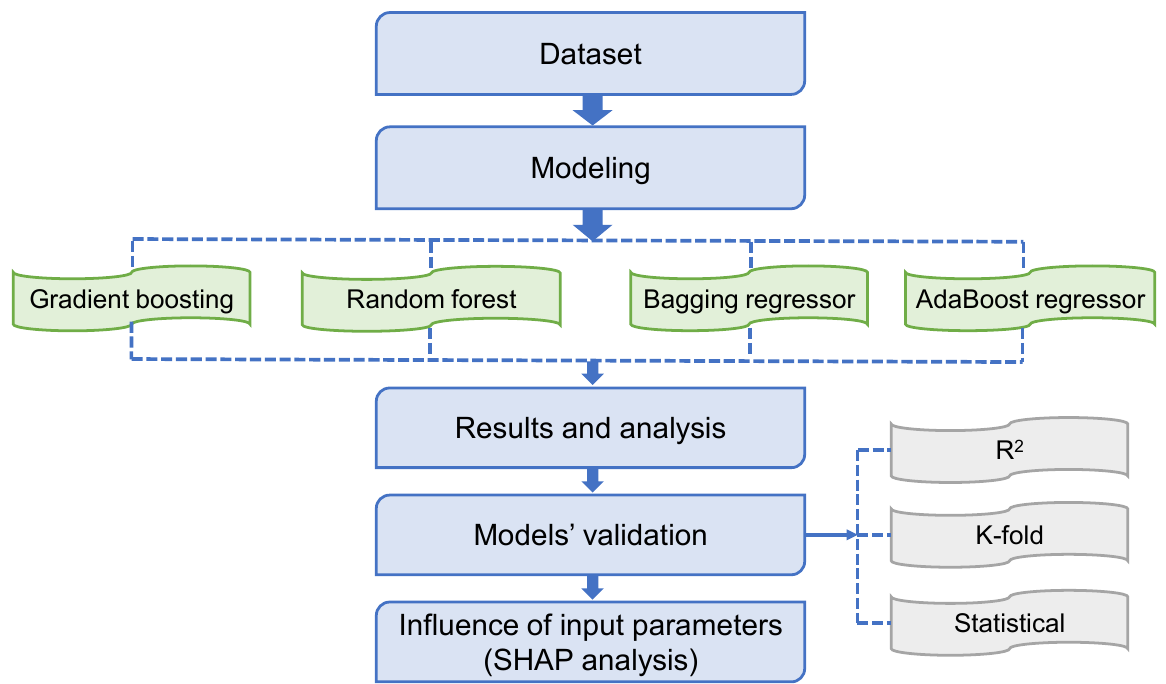
Figure 2. Sequence of the research strategy adopted.